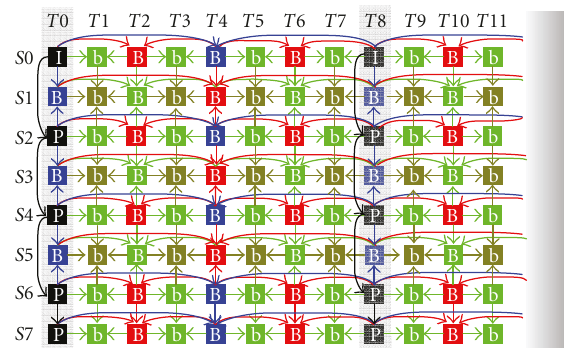
Figure 2: Typical MVC prediction